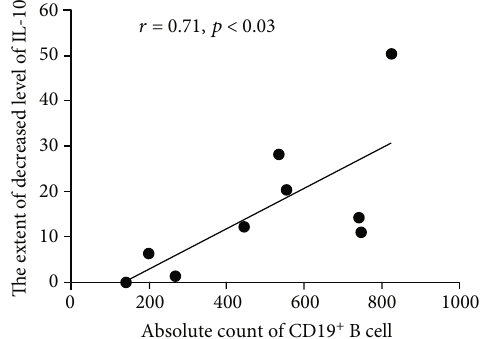
Figure 3: In the group of KD children aged ≥ 4 years, the absolute CD19 + B cell counts prior to IVIG treatment were positively correlated with the decreased expression level of IL-10 following IVIG treatment. r = 0 : 91 ; p = 0 : 03 . KD: Kawasaki disease; IVIG: immunoglobulin intravenous; IL-10: